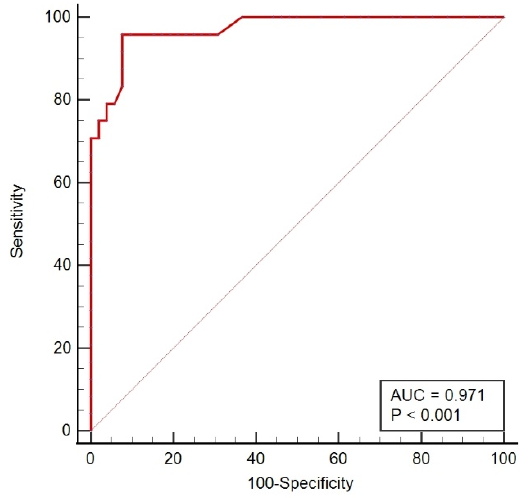
Figure 6. ROC curves of the optimal model in the validation set.